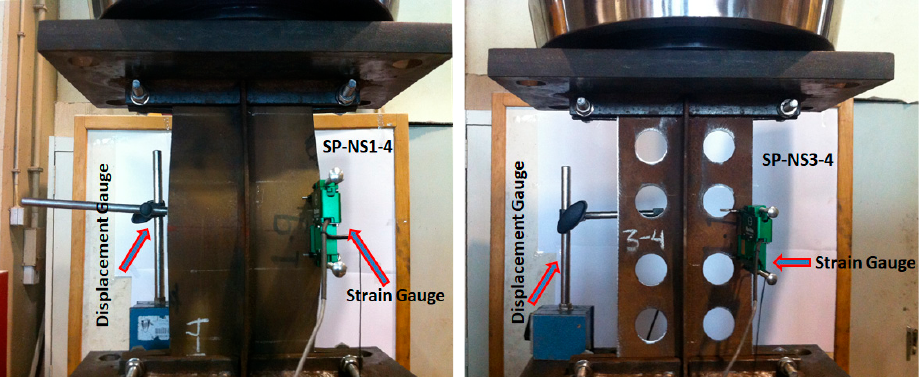
Figure 2. Compressive testing